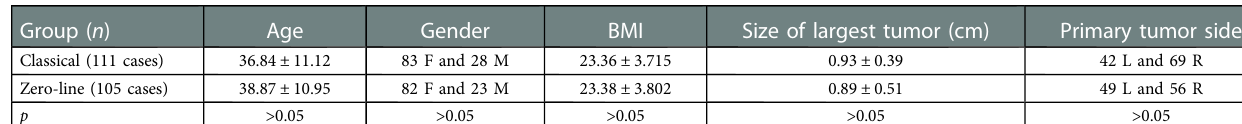
TABLE 1 General conditions of two groups.